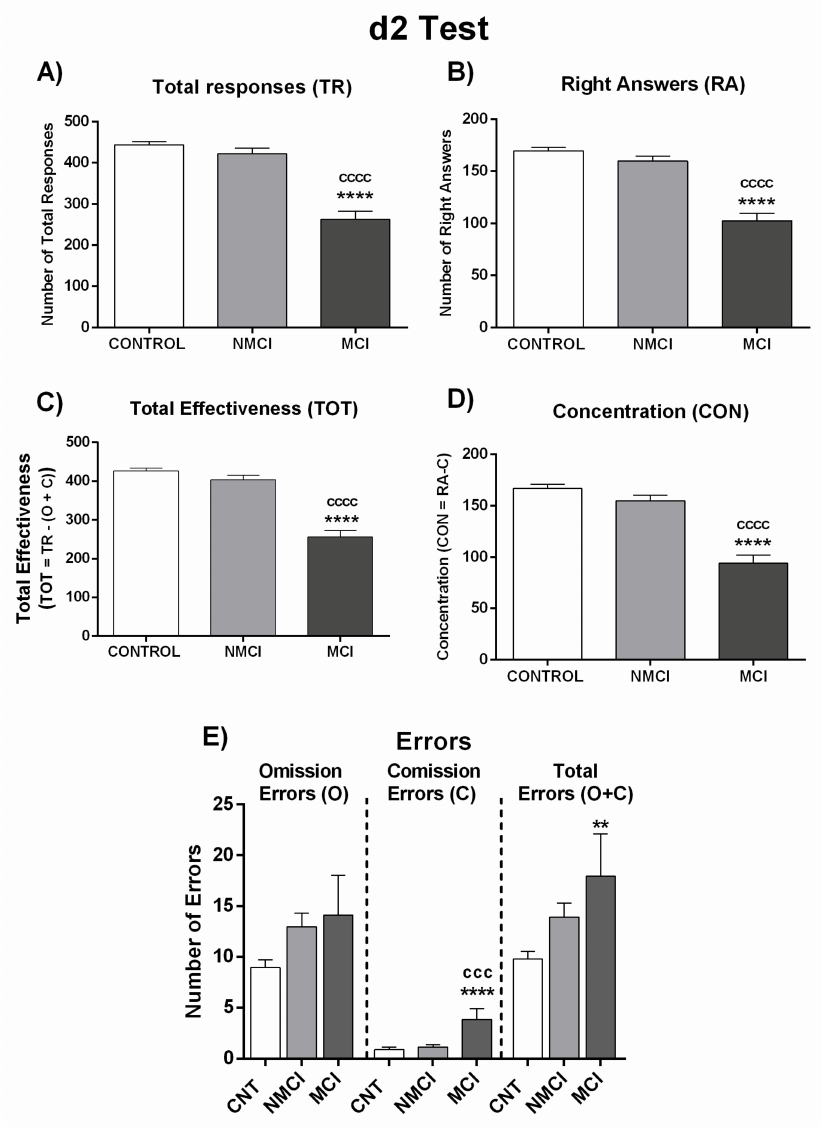
Figure 4. Performance of NAFLD patients classified by the new score as with (MCI) or without (NMCI) mild cognitive impairment in d2 test. ( A ) Number of total responses (TR), ( B ) right answers (RA), and ( C ) total effectiveness (TOT), which was calculated by: TOT= TR − (O + C). ( D ) Concentra- tion index (CON), which was calculated by: CON = RA − C. ( E ) Number of errors by Omission (O), Comission (C), and total errors (O + C). Results are the mean ± SEM. ** p < 0.01; **** p < 0.0001 vs. control group (CNT). ccc p < 0.001; cccc p < 0.0001, NASH MCI vs. NASH